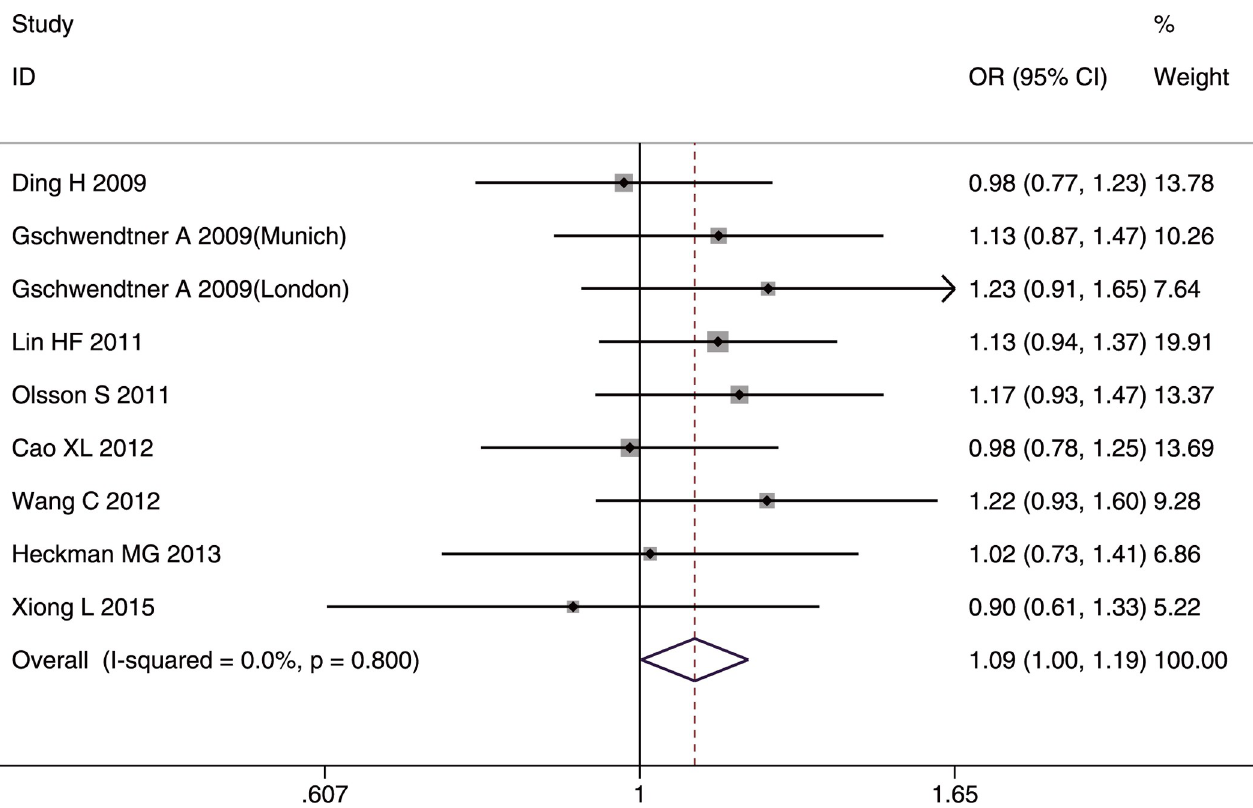
Fig 8. Forest plot of rs1333040 genotype frequency (TT vs. (CC+CT)) in the whole studied population.